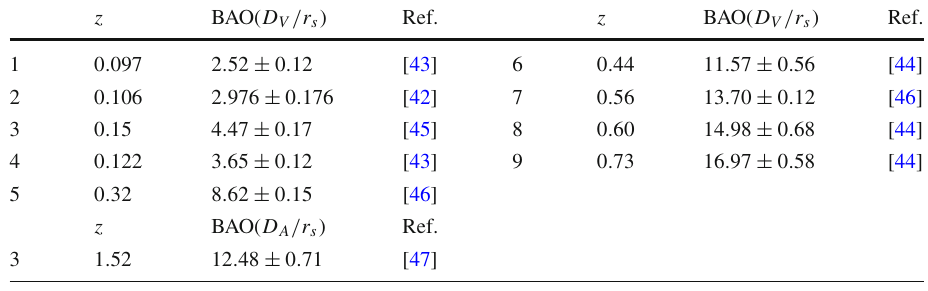
Table 1 BAO data points